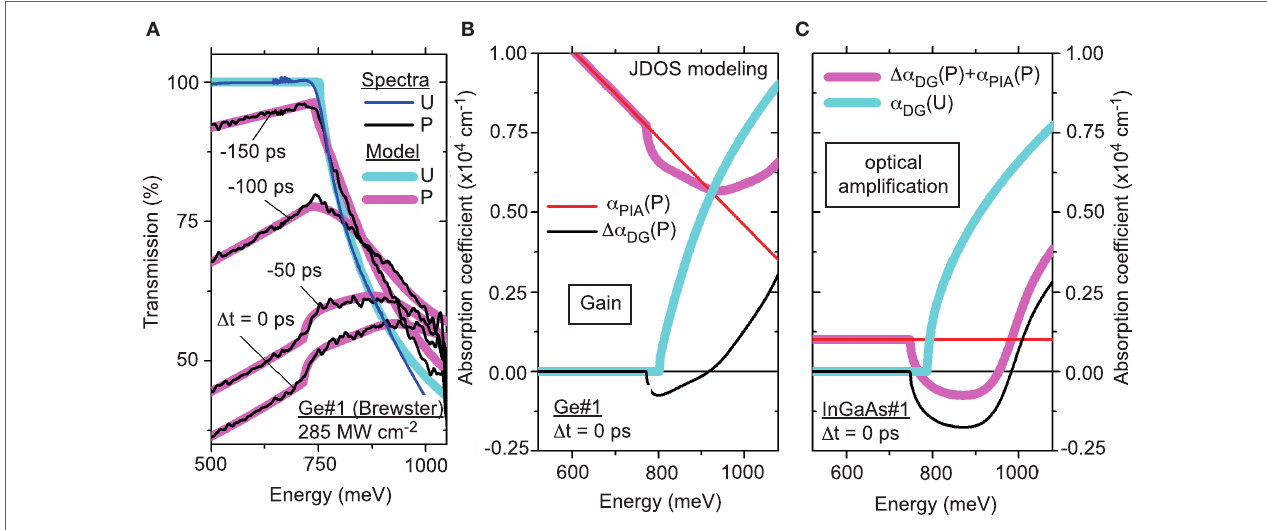
absorption (red, thin line) obtained from the spectra in (A) at 0 time delay. (C) Similar extraction of direct gap gain and losses for undoped InGaAs showing light amplification, as the gain surpasses the pump-induced losses (Carroll et al.,